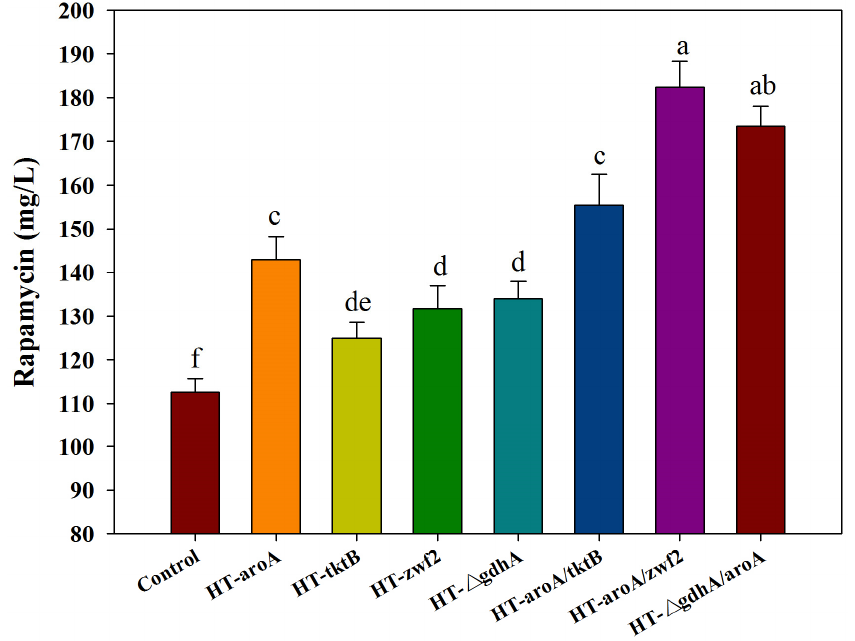
Figure 7. The effect of the single (or multiple) gene manipulation on rapamycin production. aro A: 2-dehydro-3-deoxyphosphoheptonate aldolase; tkt B: transketolase; zwf 2: glucose-6-phosphate 1-dehydrogenase; gdh A: glutamate dehydrogenase (NADP+). The significant differences ( p < 0.05) of rapamycin yields were marked with the lowercase letters among the different strains.